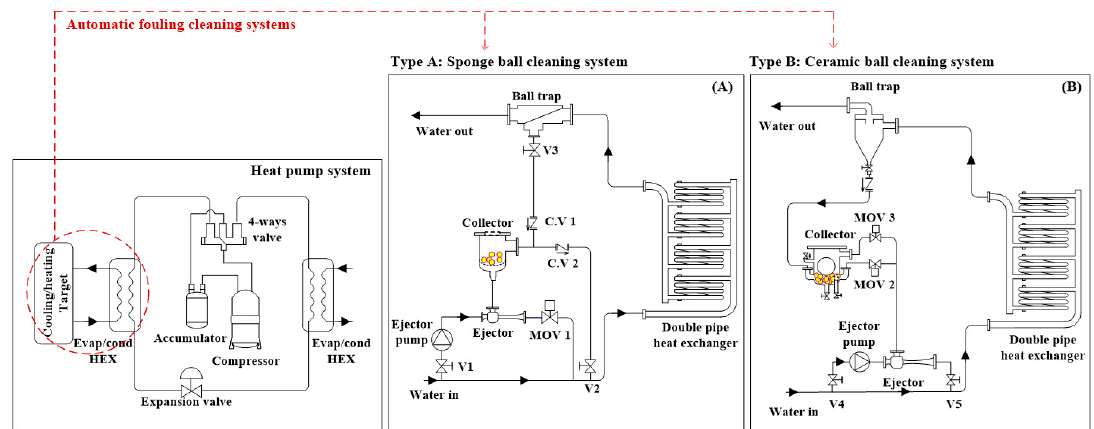
Figure 1. Schematic diagram of a heat pump system applying automatic cleaning systems.